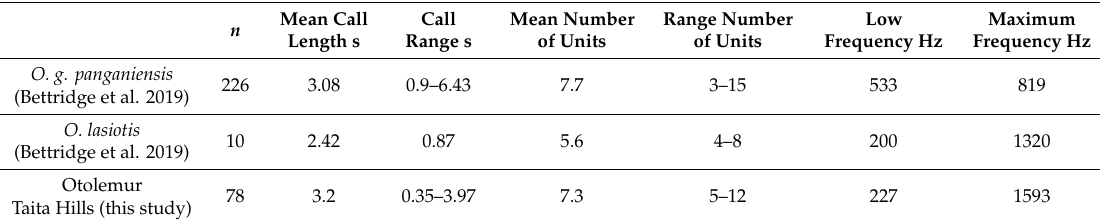
Mean Call Call Mean Number Range Number Low Maximum n Length s Range s of Units of Units Frequency Hz Frequency Hz